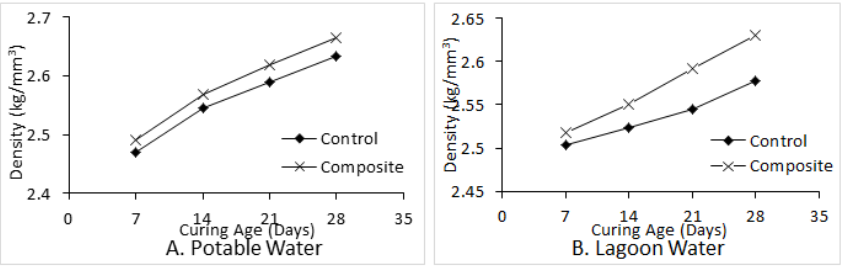
Figure 3. Variation of slump value and compacting factor of pozzolan blended steel slag aggregate